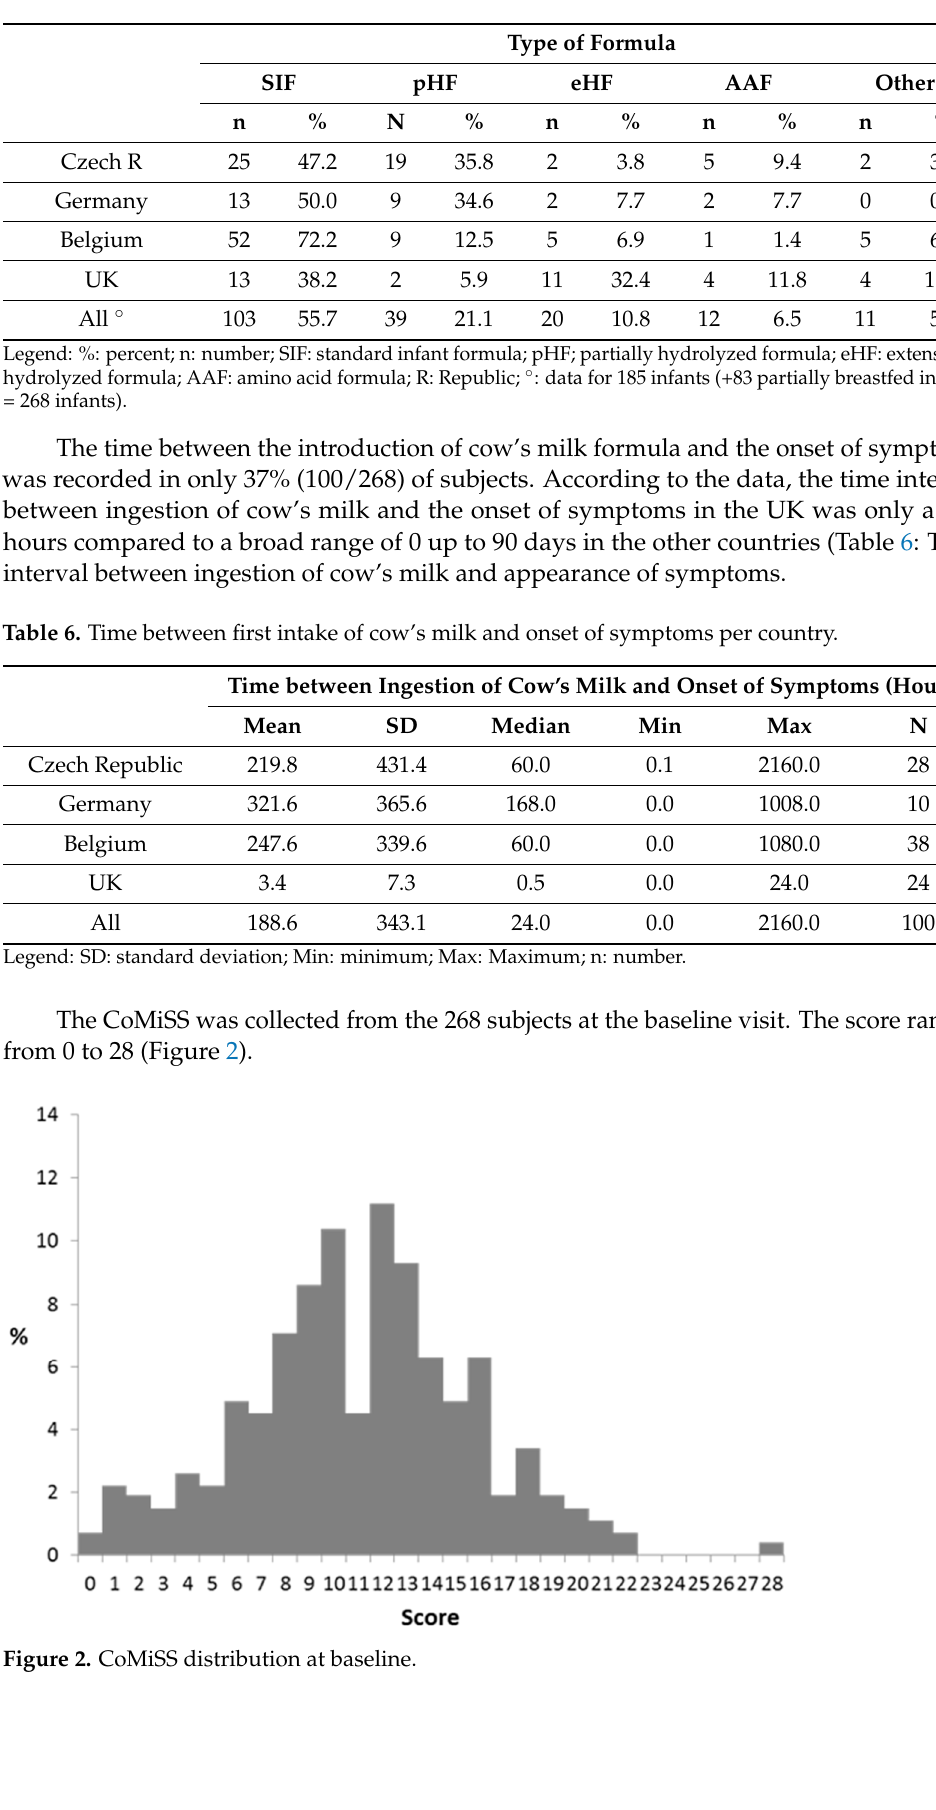
Table 5. Type of formula at inclusion visit in formula-fed or mixed breastfeeding and formula- fed infants.